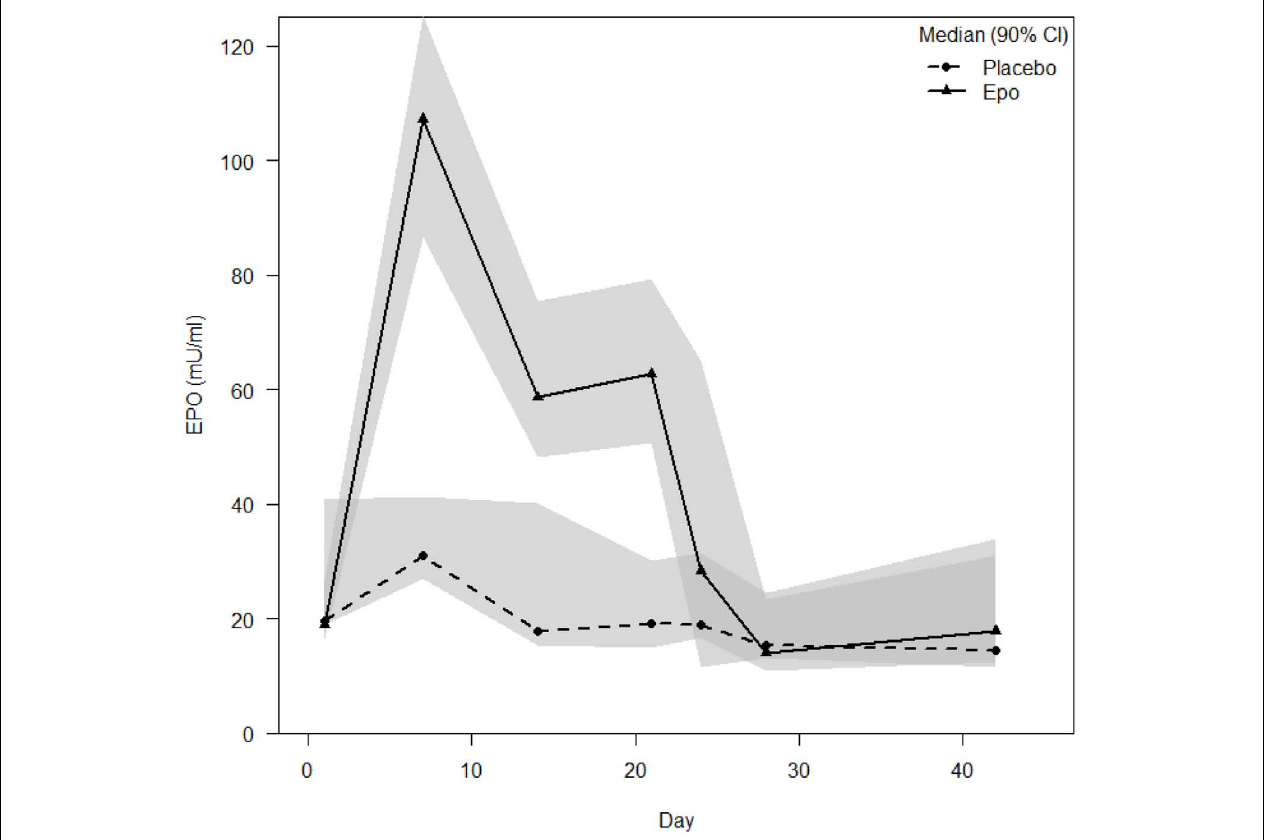
FIGURE 5 | EPO levels in the peripheral blood. Legend: Plasma EPO level data are displayed in SI units’ median with two-sided 90% confidence